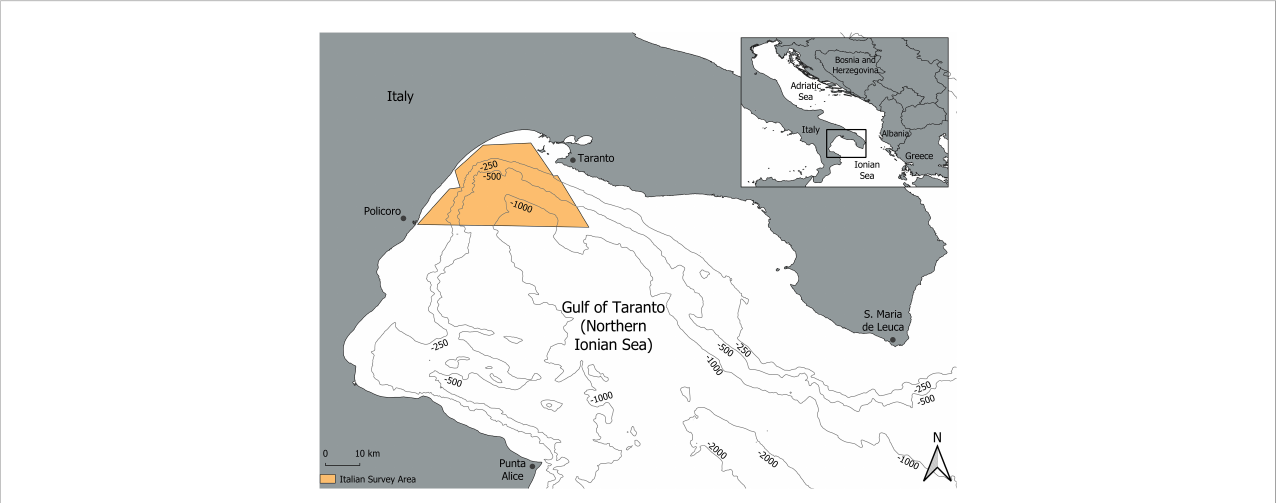
FIGURE 1 Map of the study location in the Taranto Gulf, Northern Ionian Sea, Central-Eastern Mediterranean